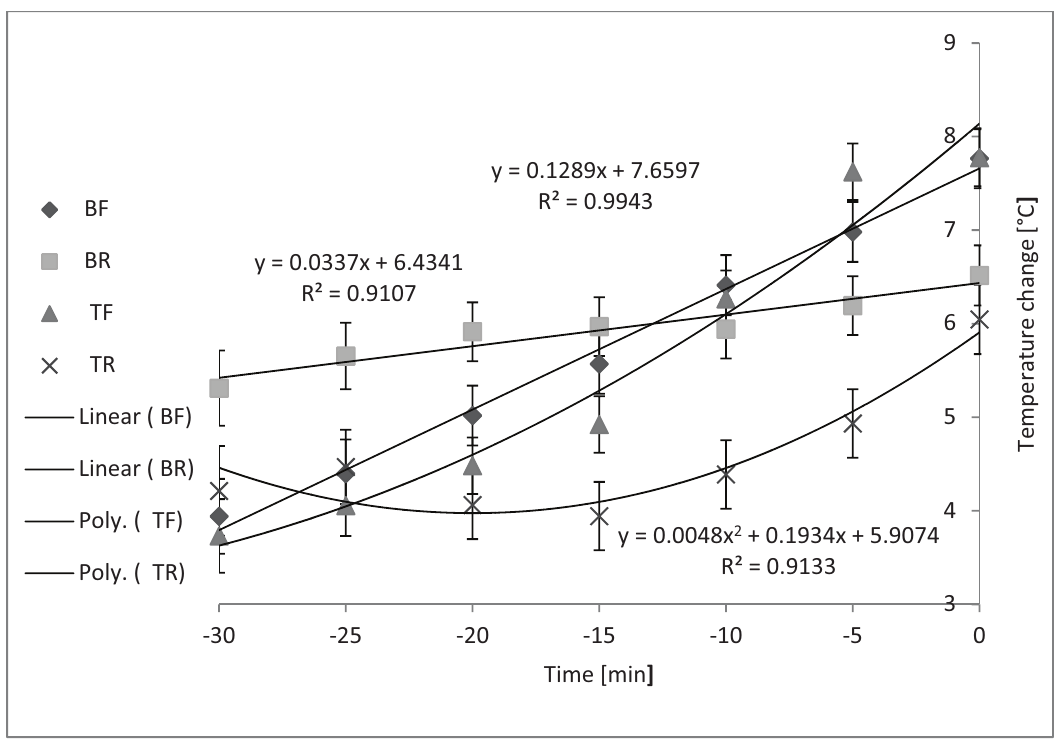
BF = bottom front, BR = bottom rear, TF = top front, TR = top rear